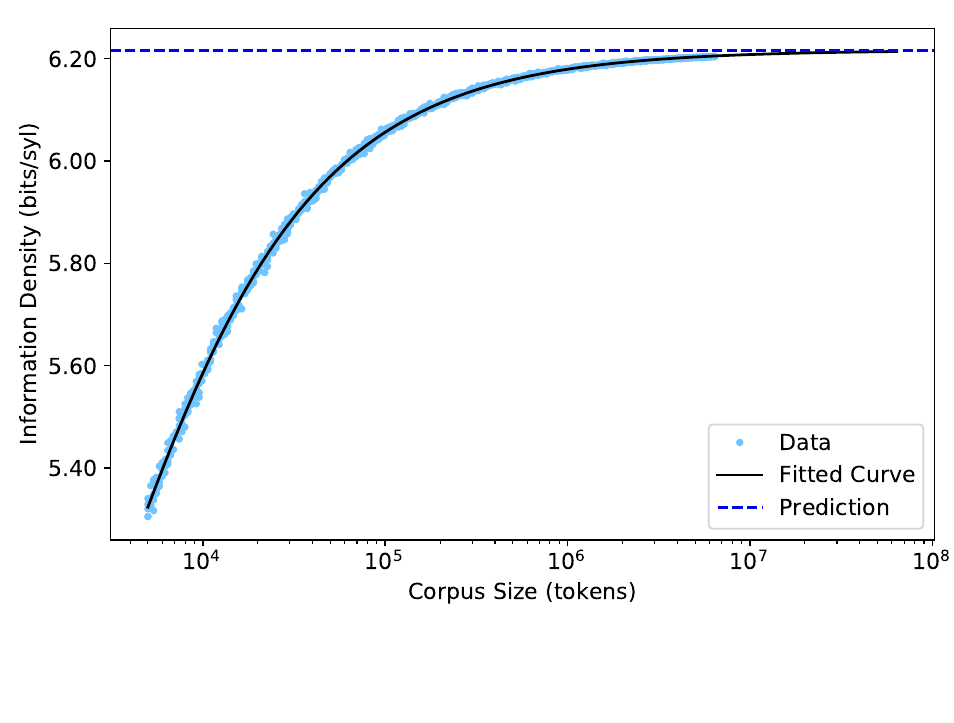
Figure 4. Estimated information density from the entire corpus